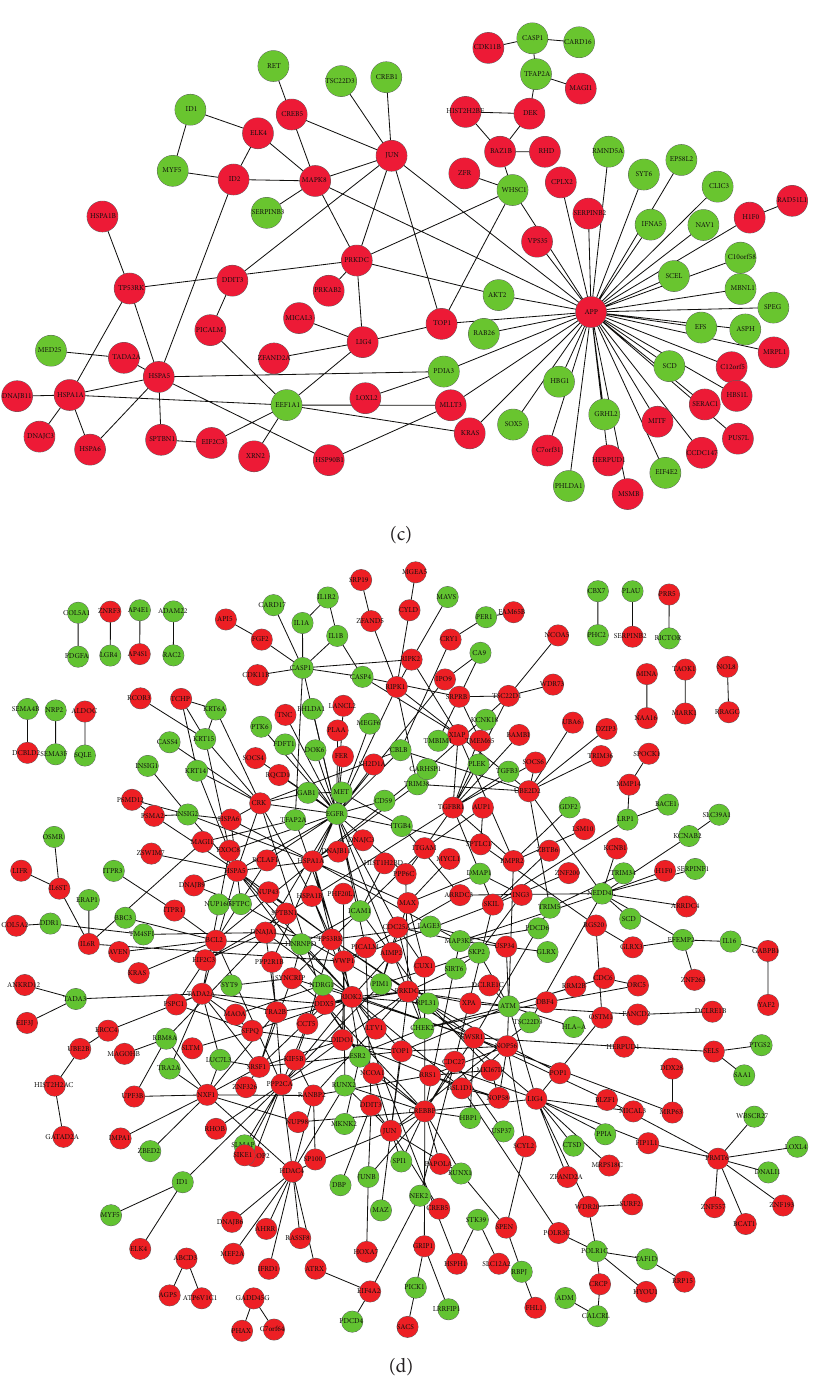
Figure 1: DEGs were mapped to the HPRD&BioGRID parent PPI network to generate PPI subnetworks. (a) PPI subnetworks of LOXL2-e13- DEGs. (b) PPI subnetworks of LOXL2-WT-DEGs. (c) Interactions between LOXL2-e13-DEGs. (d) Interactions between LOXL2-WT- DEGs. Nodes are labeled by different colors to indicate the expression trend of proteins. Green nodes represent proteins encoded by downregulated genes, while red nodes represent proteins encoded by upregulated genes. Interacting proteins without significantly different expression are represented as blue